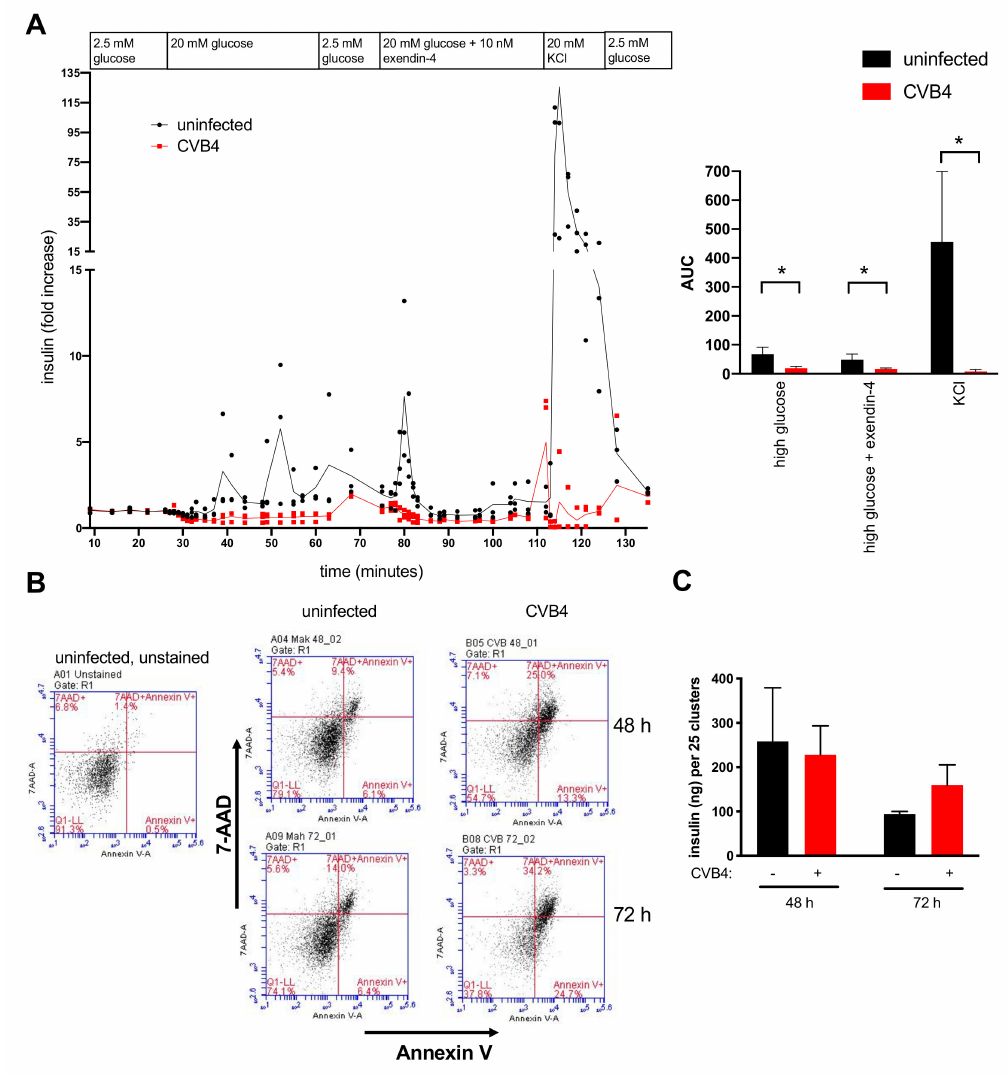
Figure 5. Assessment of perifusion, cytotoxicity, and total insulin in CVB4-infected SC- β cells. ( A ) Cells were examined by perifusion analysis at 48 h post-infection to measure insulin secretion. The data were normalized to basal insulin secretion values measured prior to challenge with high